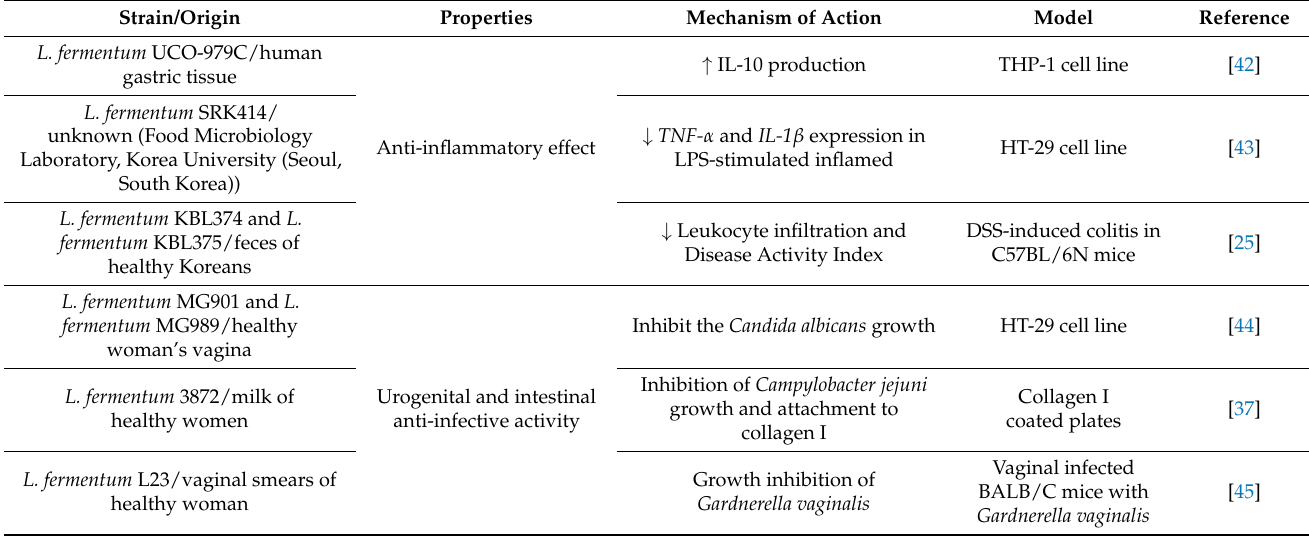
Table 1. Effects of different L. fermentum strains in preclinical